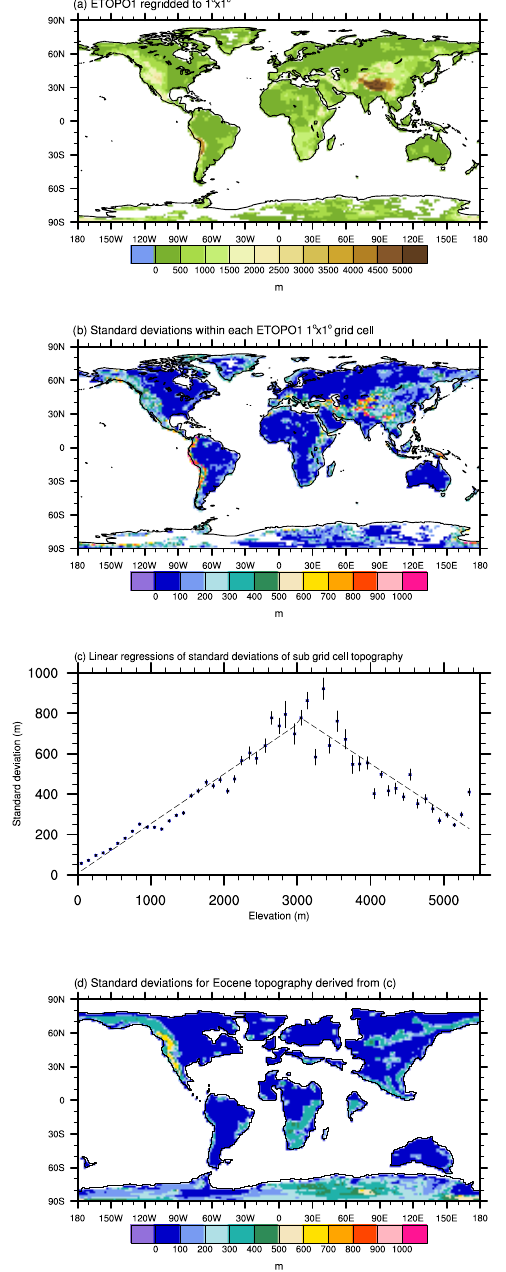
Figure 2. Estimating the standard deviation of sub grid cell ele- vations for the Eocene. (a) ETOPO1 topography downscaled from its native 1 0 × 1 0 resolution to 1 ◦ × 1 ◦ . (b) Standard deviation of 1 0 × 1 0 elevations inside each 1 ◦ × 1 ◦ grid cell. (c) Standard devi- ations from (b) area-weight averaged into 100m bins and plotted against corresponding elevation. Standard error for each bin is plot- ted. Dotted lines represent linear regressions between sea level and 3000, and 3000 and 5500m. (d) Linear regressions from (c) applied to Eocene topography (Fig. 1c). See text for